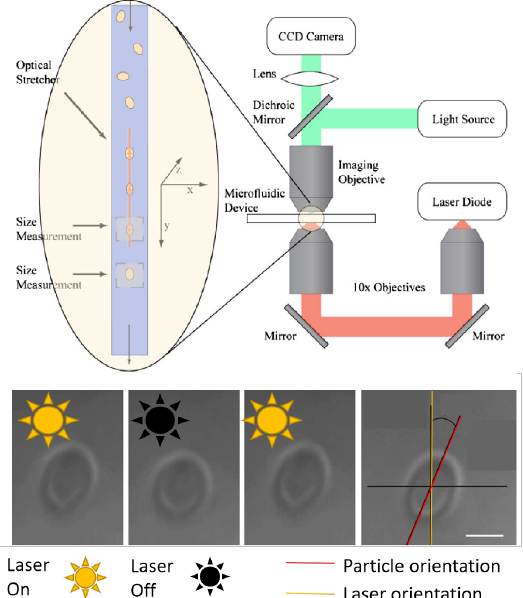
Figure 15. Near field optical forces applied to studies on the elasticity of RBC’s: sequential images of an RBC repeatedly stretched with laser diode. Scale bar = 4 µ m. Adapted from [103], SPIE digital library. Open